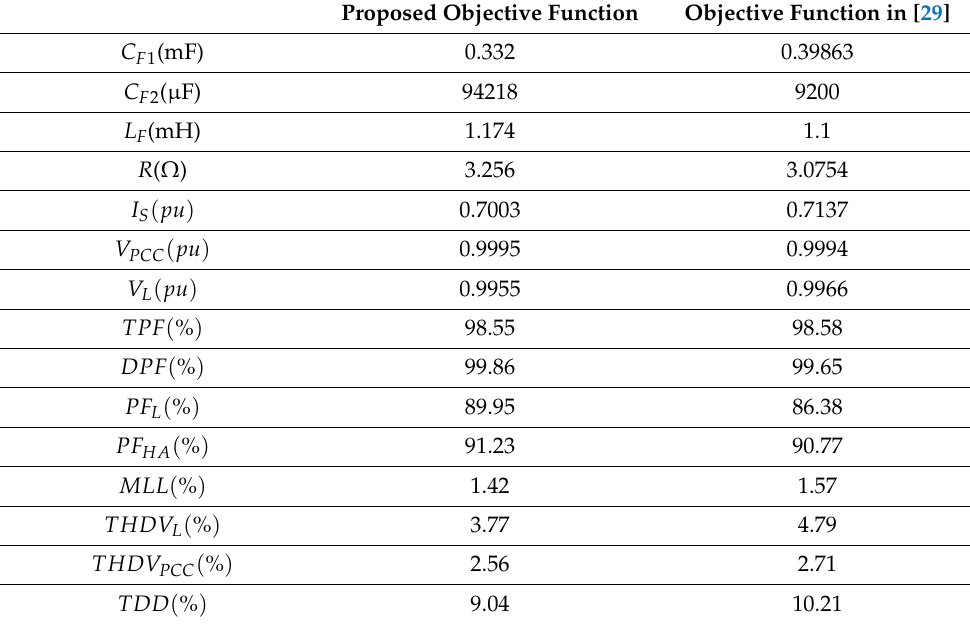
Table 7. Comparison of the POF and the represented OF in [29] based on the Harris Hawks algorithm. Proposed Objective Function